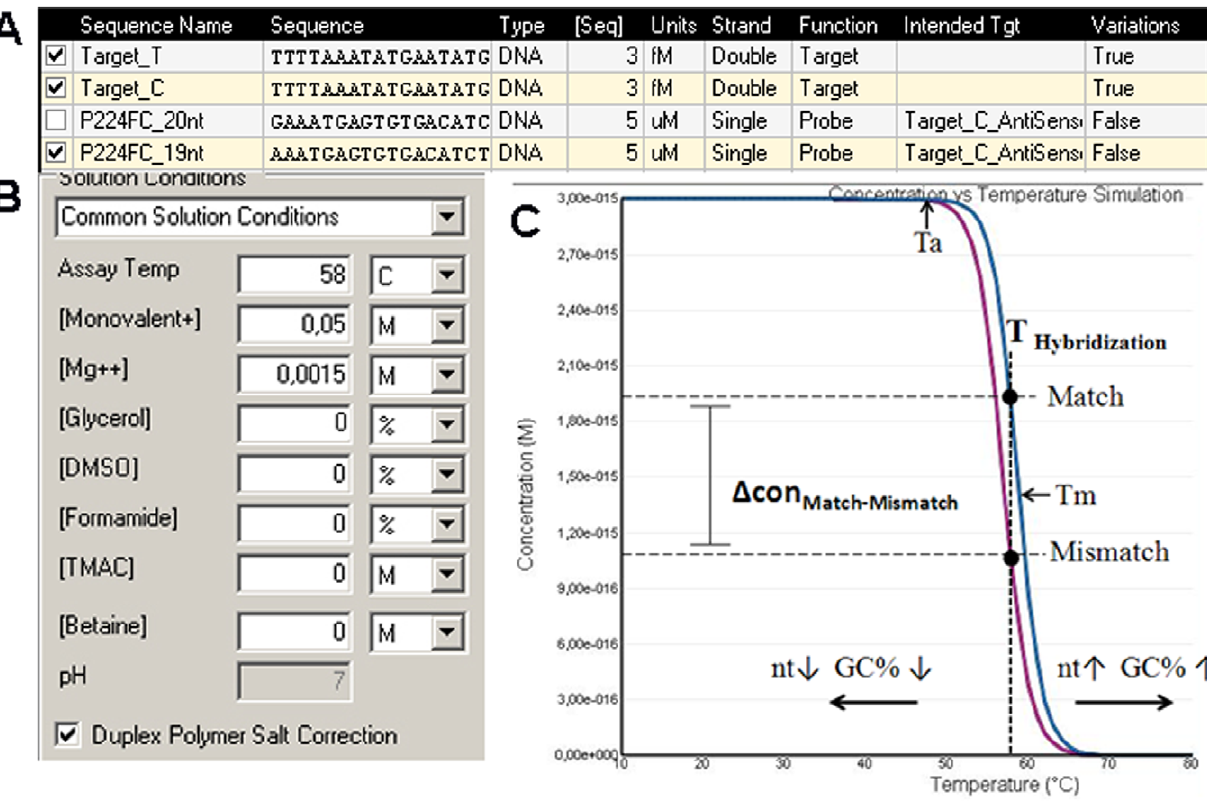
Figure 2. Direct comparison of the thermodynamic stability of match and mismatch using VisualOMP . The program allows the simulation of the concentration of hybridized matches and mismatches by adding the starting concentration (A) of the target and probe, as well as assay parameter (B) under the solution conditions. (C) Simulation of concentration versus temperature. Schematic representation of the comparison between match and mismatch by concentrations. Ta, optimal annealing temperature for PCR; Tm, melting temperature. Horizontal arrows indicate a switch in the hybridization curve for decreasing ( Q ) or increasing ( q ) probe length (nt) and G/C content (GC%).